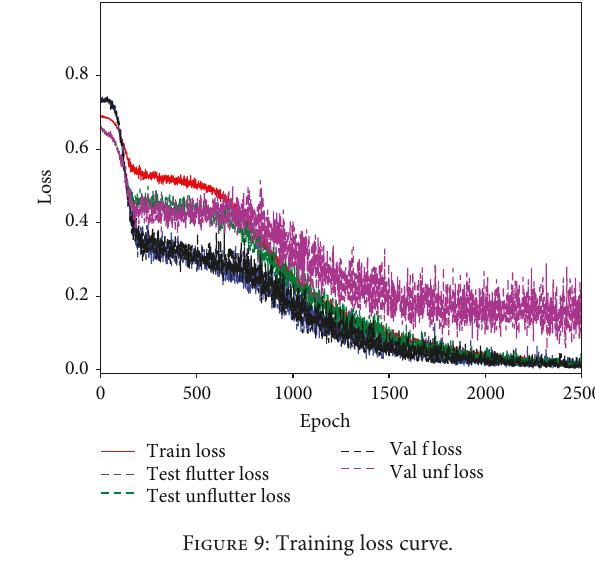
Figure 7: Training loss curve.